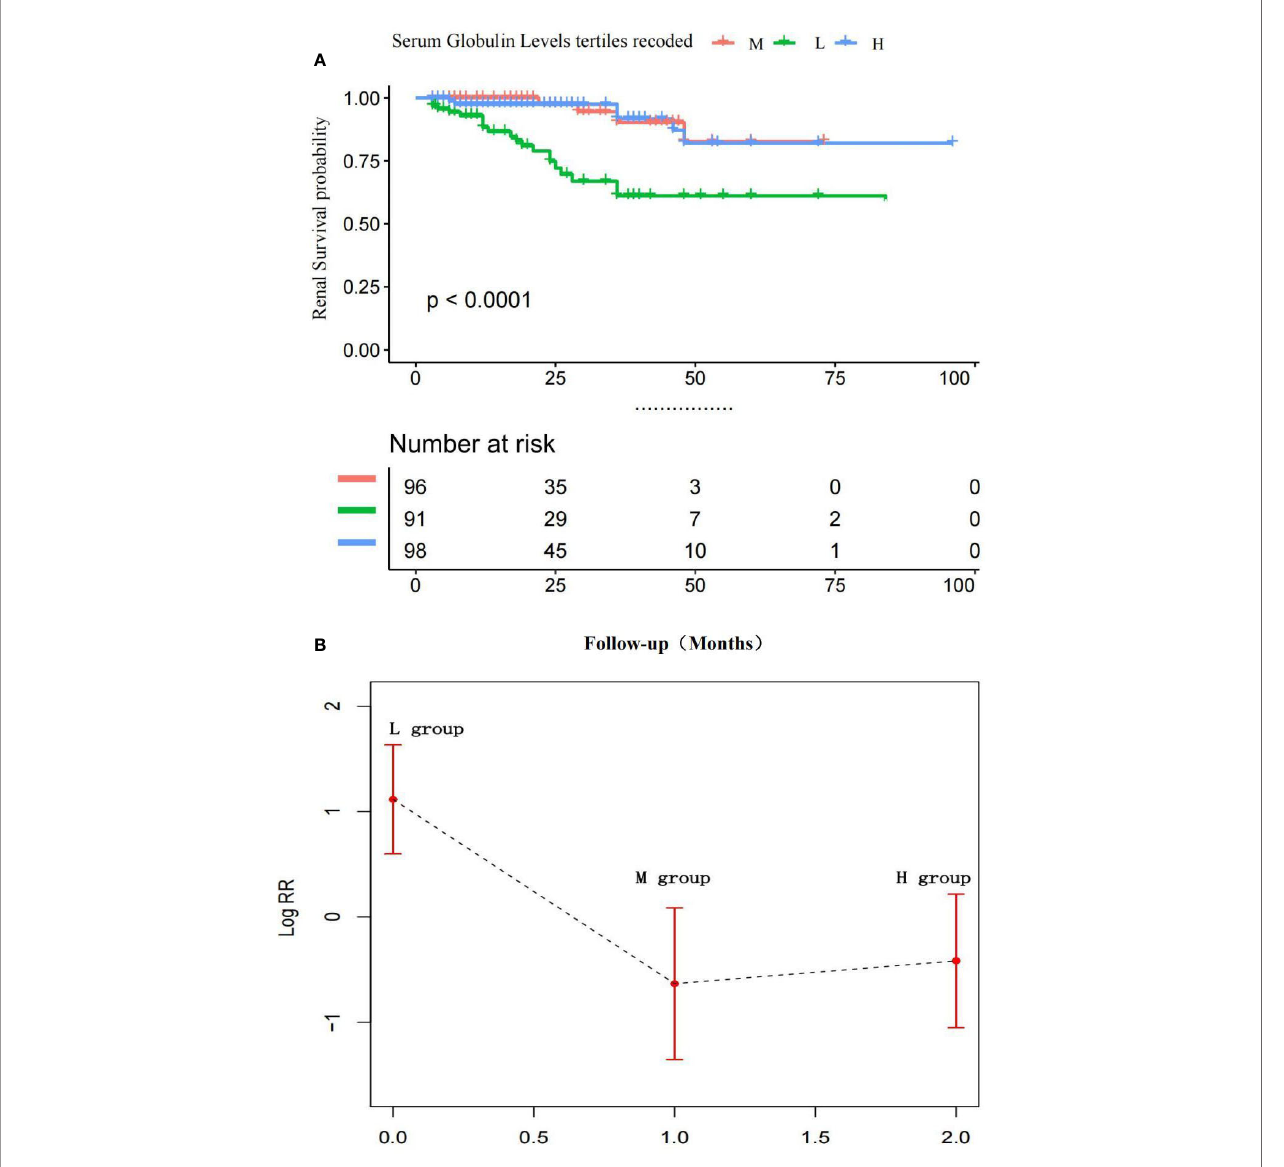
FIGURE 4 | (A) Adjusted Kaplan-Meier curves of ESRD outcome according to serum globulin levels.Renal survival was lowest In the L group, Renal survival analysis between the H and M groups was not signi fi cantly different. P > 0.01 M vs. H group; P < 0.01 M vs. L group and H vs. L group. (B) Adjusted Log risk ratios (RRs) for ESRD by tertiles of serum globulin levels. A L-shaped association was shown to exist between the serum globulin level and ESRD in patients with